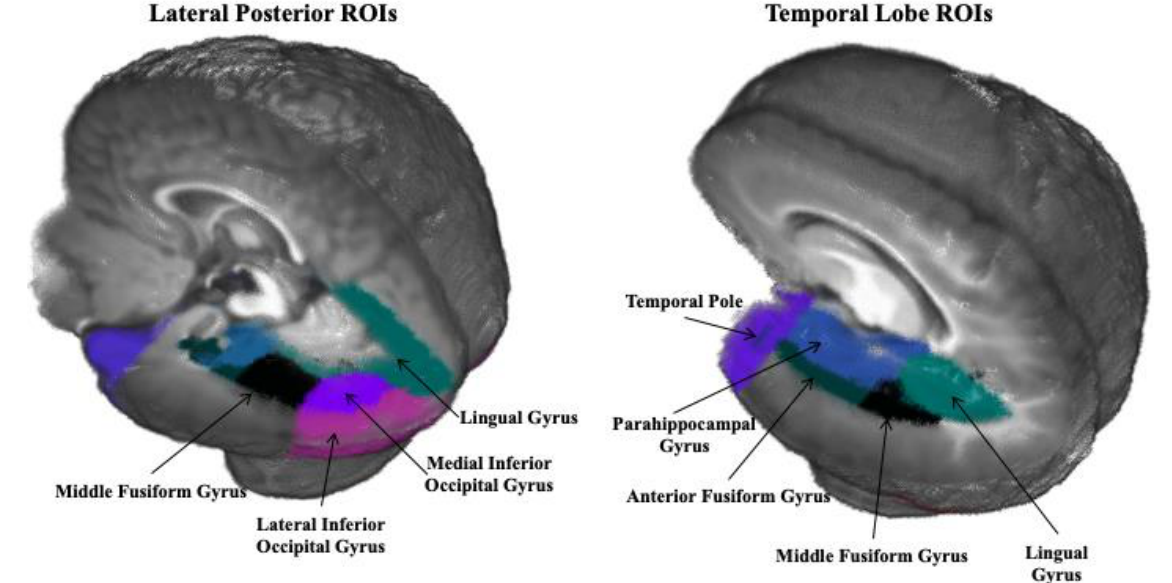
Figure 2. Regions of interest (ROIs) shown on a 6-month-old average age-appropriate template (Guy, Zieber, and Richards, 2016 [13]). Zieber, and Richards, 2016